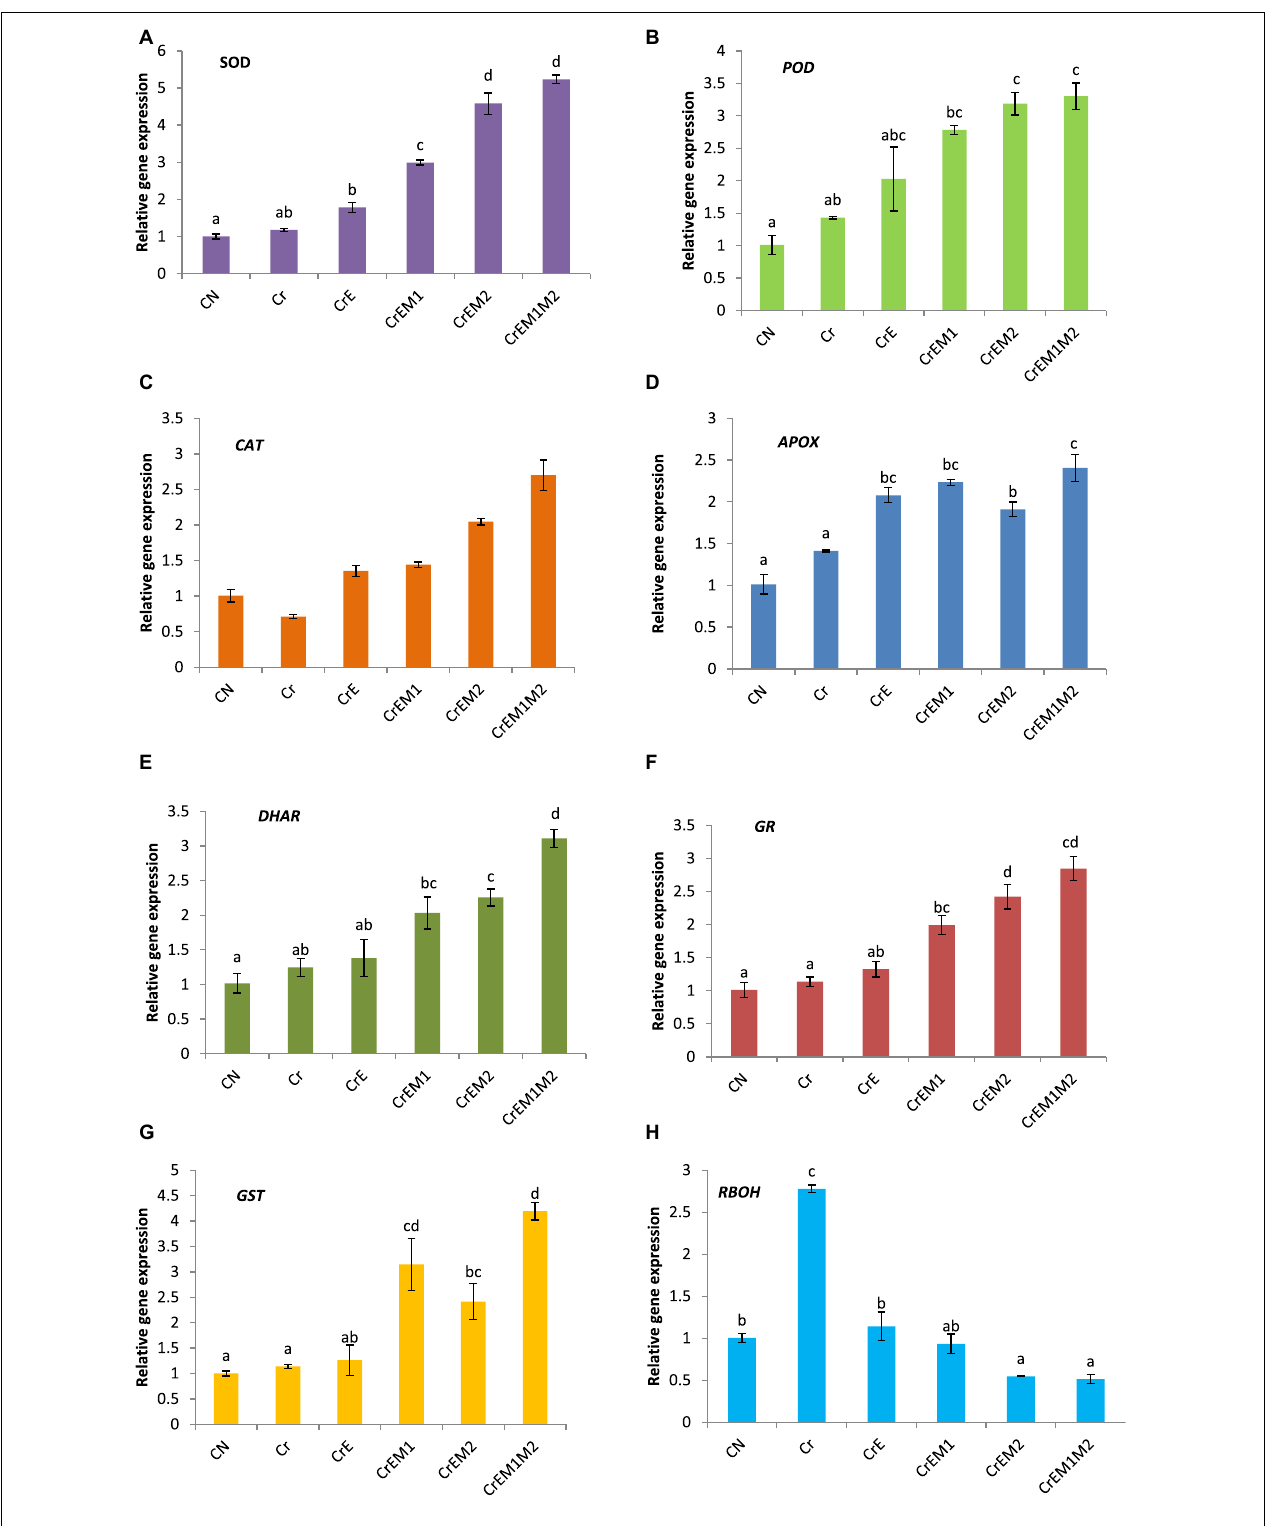
FIGURE 6 | Effect of PGPR [ Pseudomonas aeruginosa (M1) & Burkholderia gladioli (M2)] and earthworms [ Eisenia fetida (E)] on the gene expression of (A) SOD, (B) POD, (C) CAT, (D) APOX, (E) DHAR, (F) GR, (G) GST, and (H) RBOH in 10-day-old B. juncea seedlings, under chromium (Cr) stress. Data are presented as means of 3 independent replicates ± S.E (standard error). Different letters on the bar graphs indicate that mean values of the treatments are significantly different at p ≤ 0.05 (Tukey’s test).